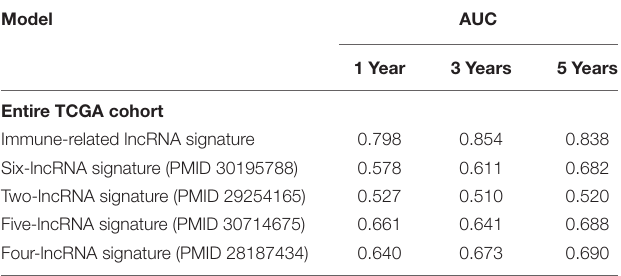
TABLE 5 | Comparison of the immune-related lncRNA signature with four other lncRNA